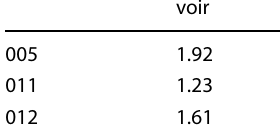
Table 3 Decline ration of candidate well to target